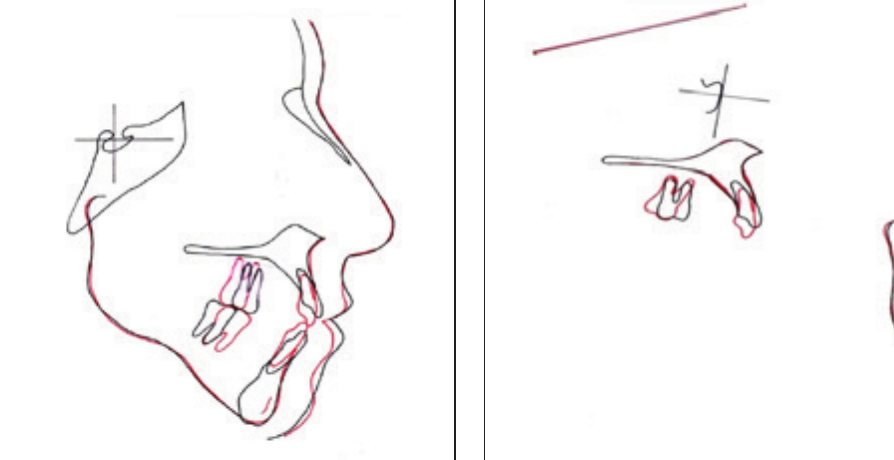
Figure 10. Total superimpositions done according to Bjork’s structural superimposition technique.